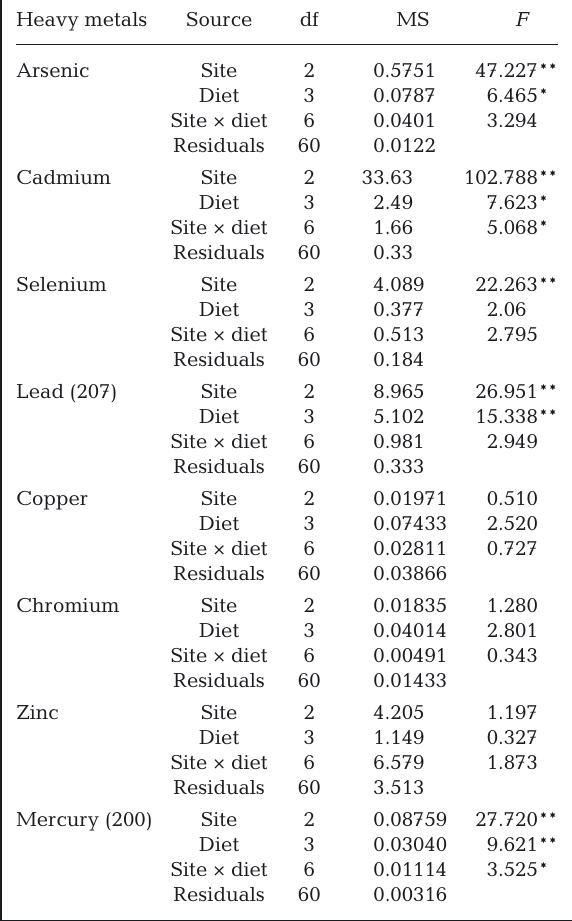
initial collection (7.6 ± 0.3%) (Fig. 6a). Conversely, COOLING urchins had a mean GI of 8.5 ± 0.5%, which was an increase of 12.4% compared to the ini- tial collection (Fig. 6a). There was no significant dif- = 0.1, p > 0.05) or wet ference in diameter ( F 1,10 = 0.1, p > 0.05) between treatments. weight ( F 1,10 During the experiment, 20% of WARM and 5% of COOLING urchins died, which was a significant dif- ference in mortality between treat ments (log rank test = 4.9, df = 1, p < 0.05). Of the WARM mortalities, one- third had le sions on their test, while no COOLING urchins had visible lesions. Half of all deaths occurred in the last week of the experiment.